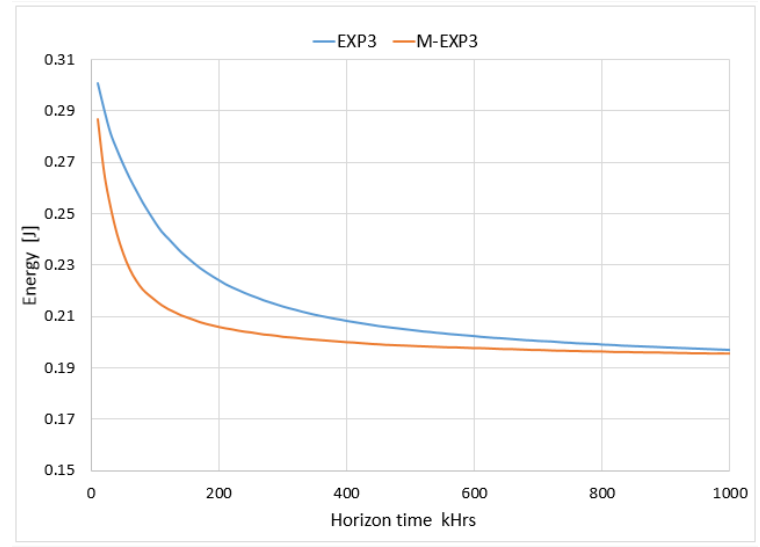
Figure 4. Comparison of the energy consumed per successful transmission packet per node.